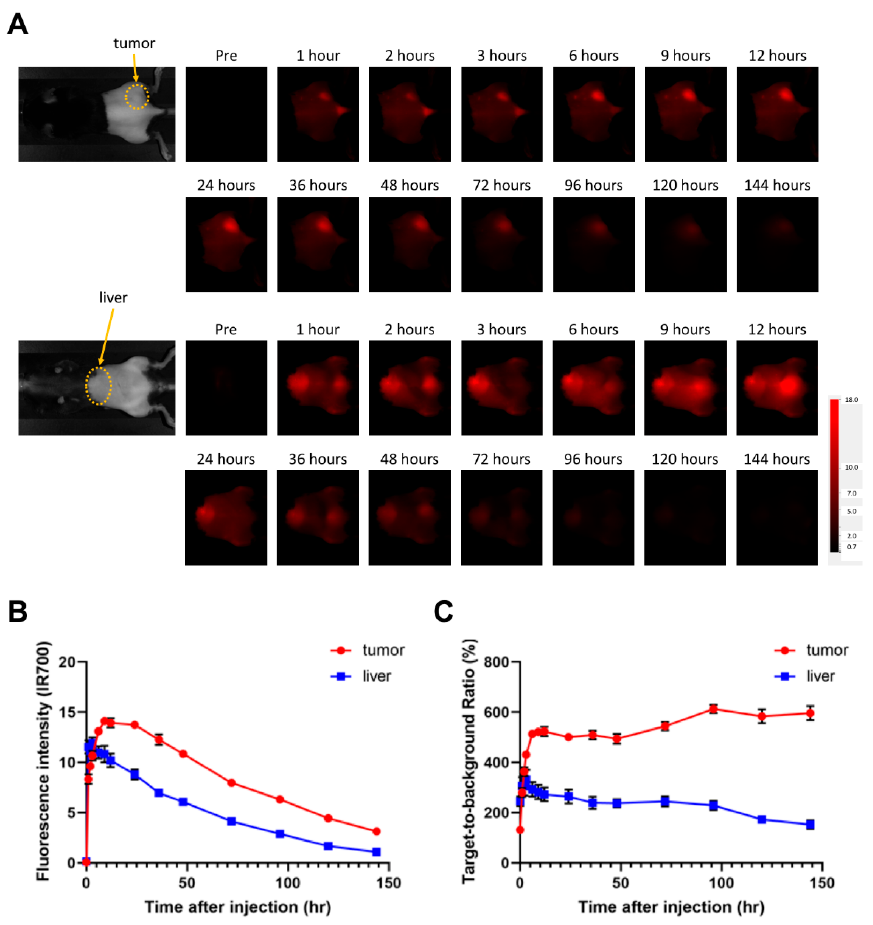
Figure 2. Biodistribution of α GD2-IR700 in EL4-luc tumor bearing mice. ( A ) In vivo serial fluo- rescence images of the EL4-luc tumor-bearing mice. Mice were intravenously administered with α GD2-IR700, and IR700 fluorescence images were obtained at the time points indicated. ( B ) Changes in IR700 fluorescence intensity in tumor and liver. Data are shown as mean ± SEM. Data were obtained from seven animals at each time point. ( C ) Changes in target-to-background ratios in tumor and liver. Data are shown as mean ± SEM. Data were obtained from seven animals at each time